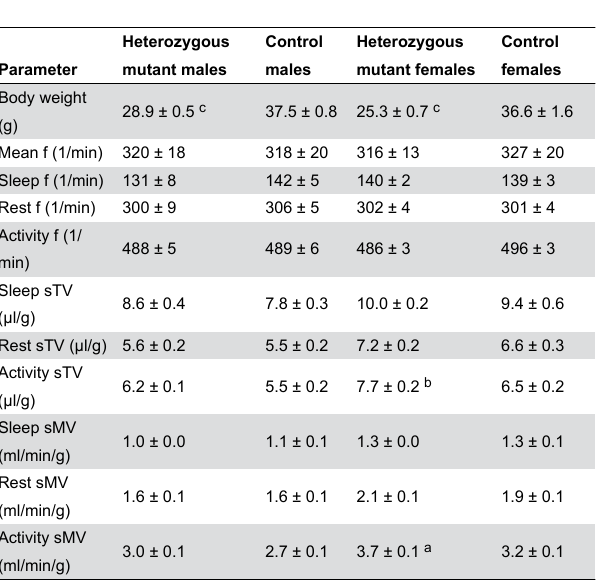
Table 6. Analysis of lung function in line Umod C93F at 38 weeks of